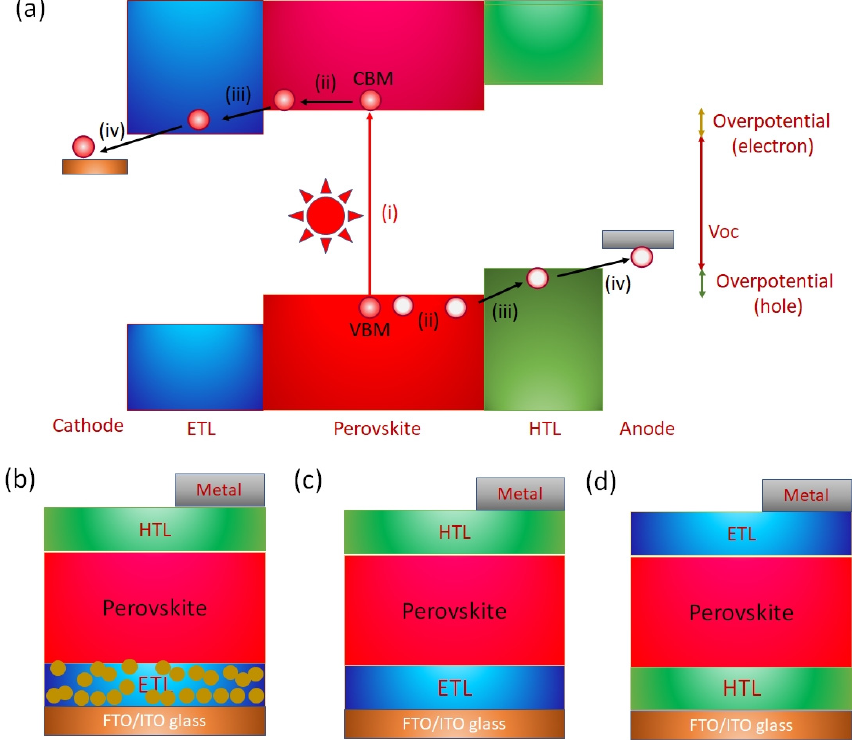
Figure 9. ( a ) Schematic diagram showing the working principle of perovskite solar cells, ( b ) Structure of normal/regular mesoscopic n-i-p solar cells, ( c ) Structure of normal structure planer n-i-p solar cells, ( d ) Structure of planer p-i-n (inverted) solar cells.